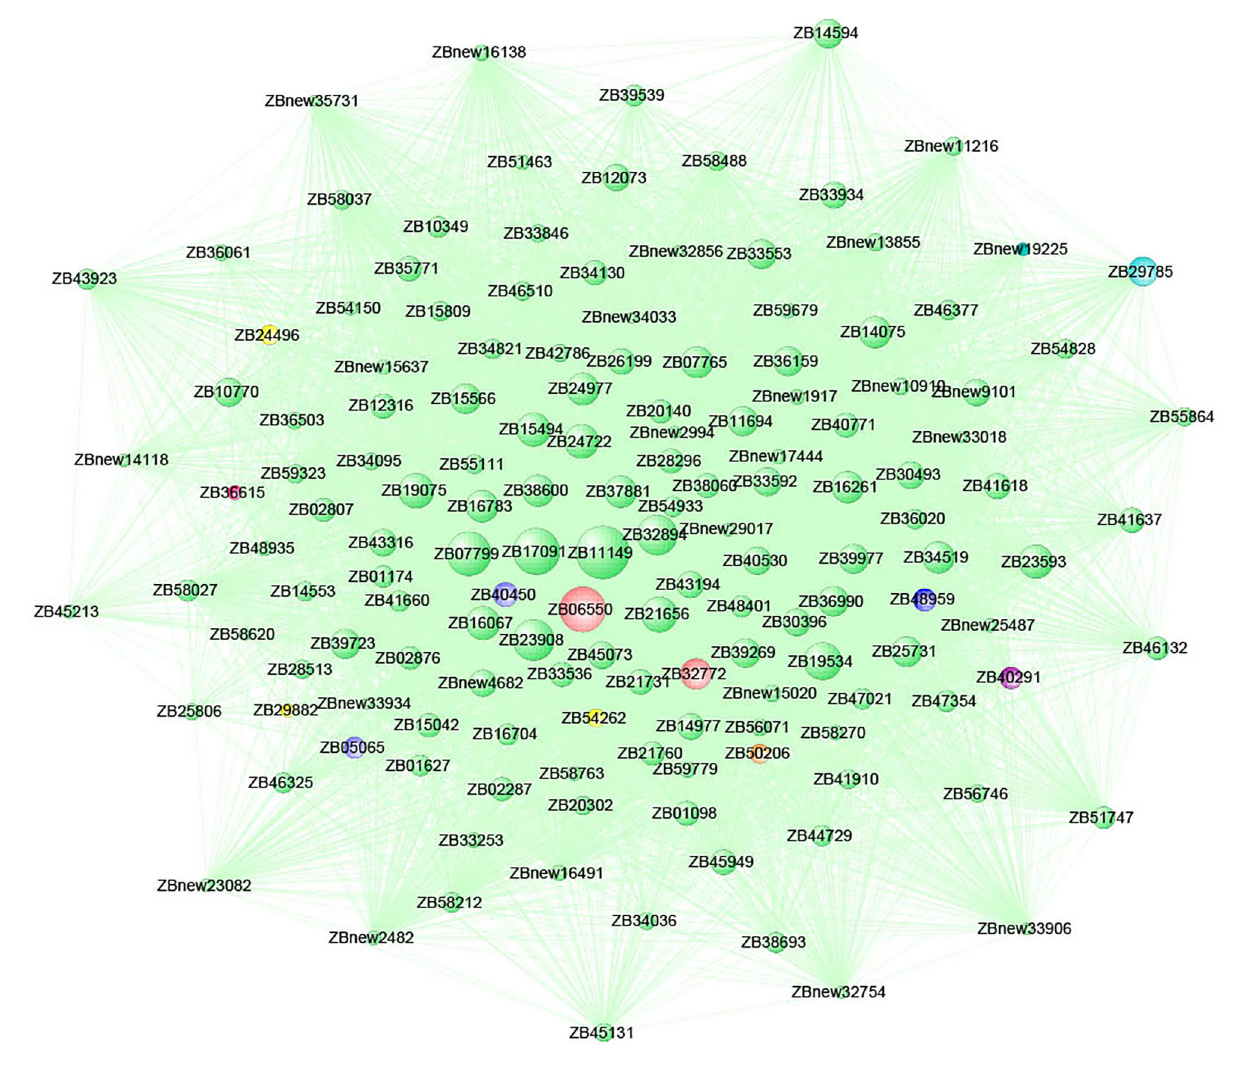
FIGURE 11 | Co-expression network of the top 150 hub genes from the MEcoral1